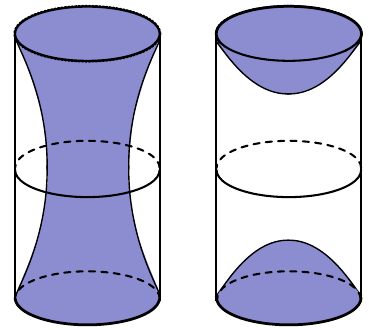
Figure 7 . Euclidean gravity solutions corresponding to the CFT path integral for h B j e (cid:0) 2 (cid:28) 0 H j B i . The boundary geometry is a cylinder S d (cid:0) 1 (cid:2) [ (cid:0) (cid:28) 0 ; (cid:28) 0 ]. The phase with a connected ETW brane con(cid:12)guration (left), dominant for small (cid:28) 0 , gives rise to a Lorentzian black hole